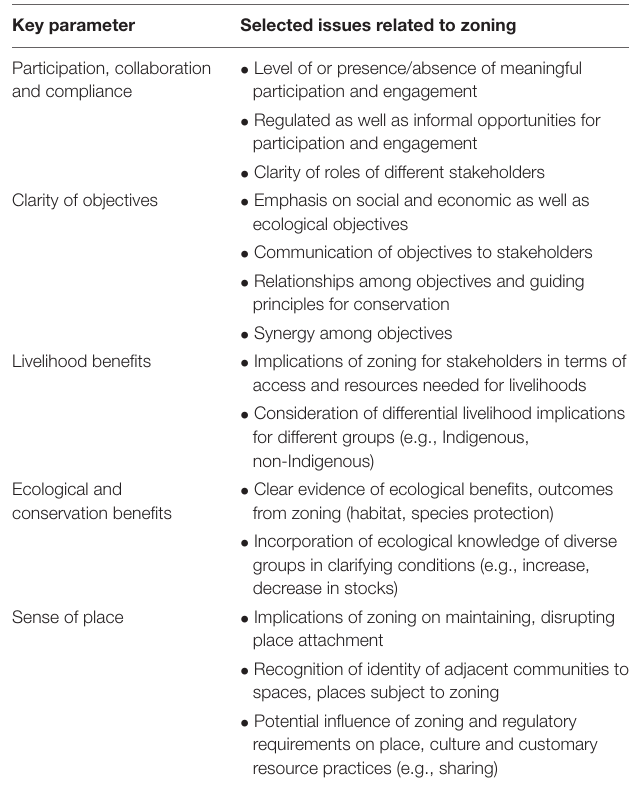
TABLE 1 | Framework for comparative assessment of zoning and governance